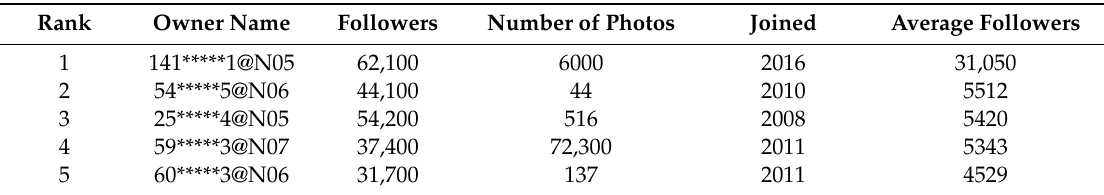
Table 6. Photographer information components.